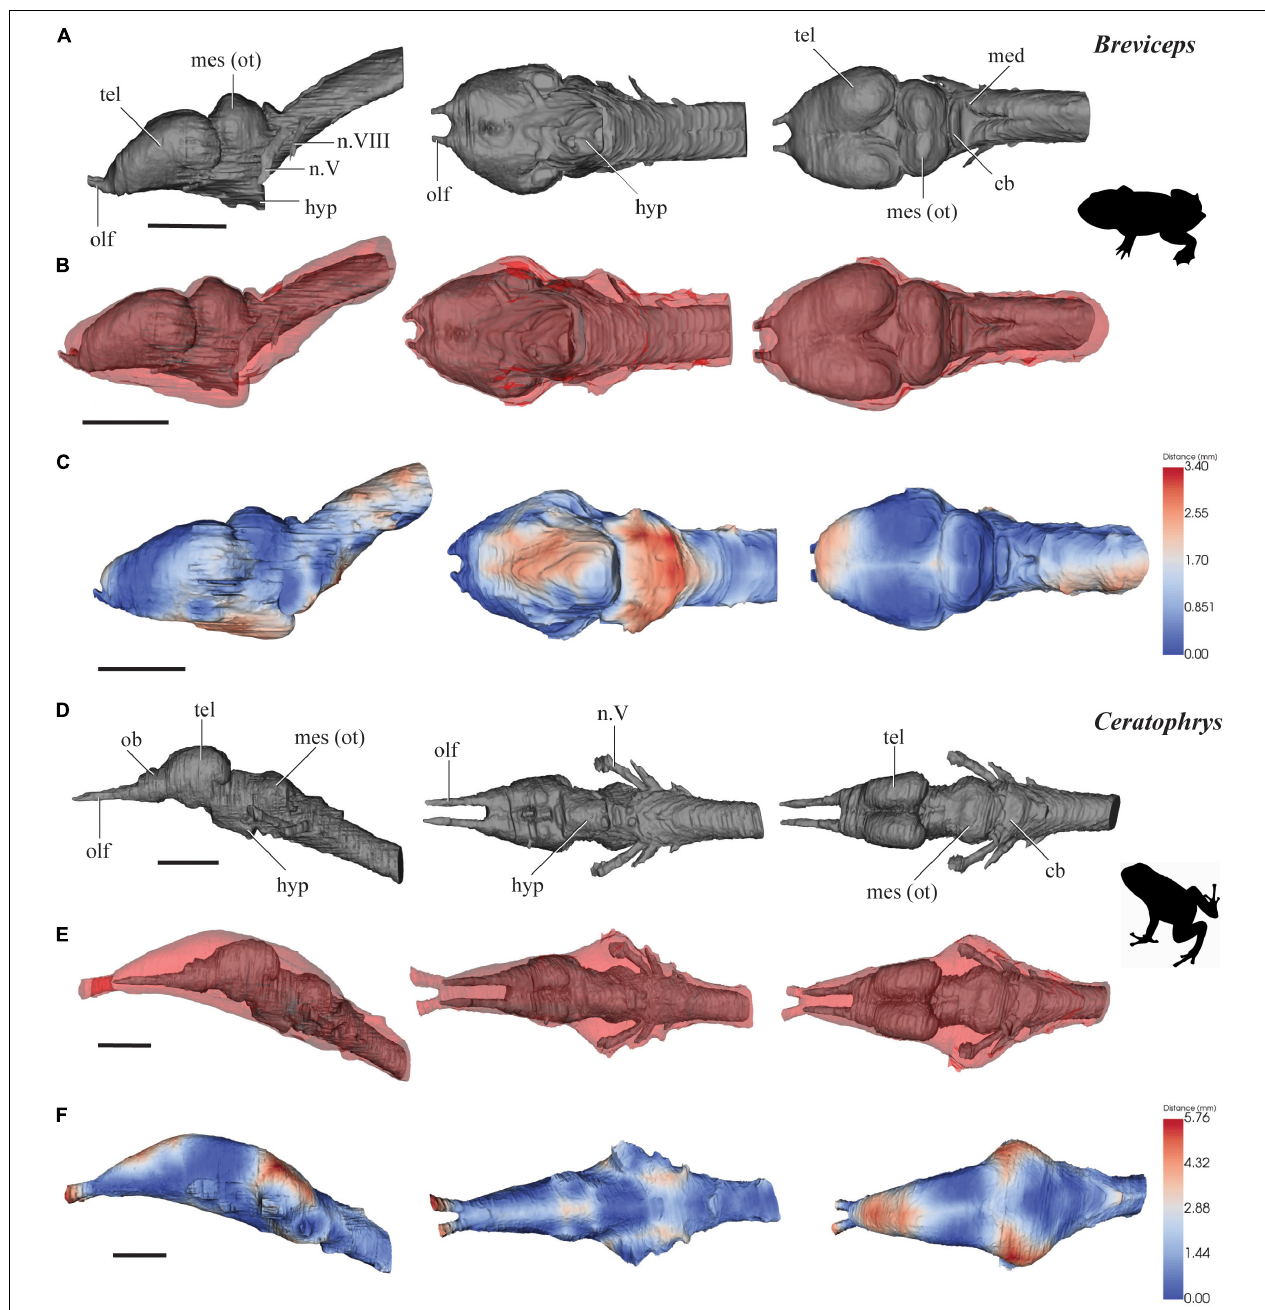
FIGURE 1 | 3D models of brains (gray), endocasts (red), and surface-surface distance heatmaps of two anurans in left lateral, ventral and dorsal views. (A–C) Breviceps ; (D–F) Ceratophrys . Anterior to the left. cb, cerebellum; hyp, hypophysis; med, medulla oblongata; mes (ot), mesencephalon/optic tectum; tel, telencephalon; ob, olfactory bulb; olf, olfactory tract; n.V, trigeminal nerve complex; n.VIII, auditory nerve. Scale 10